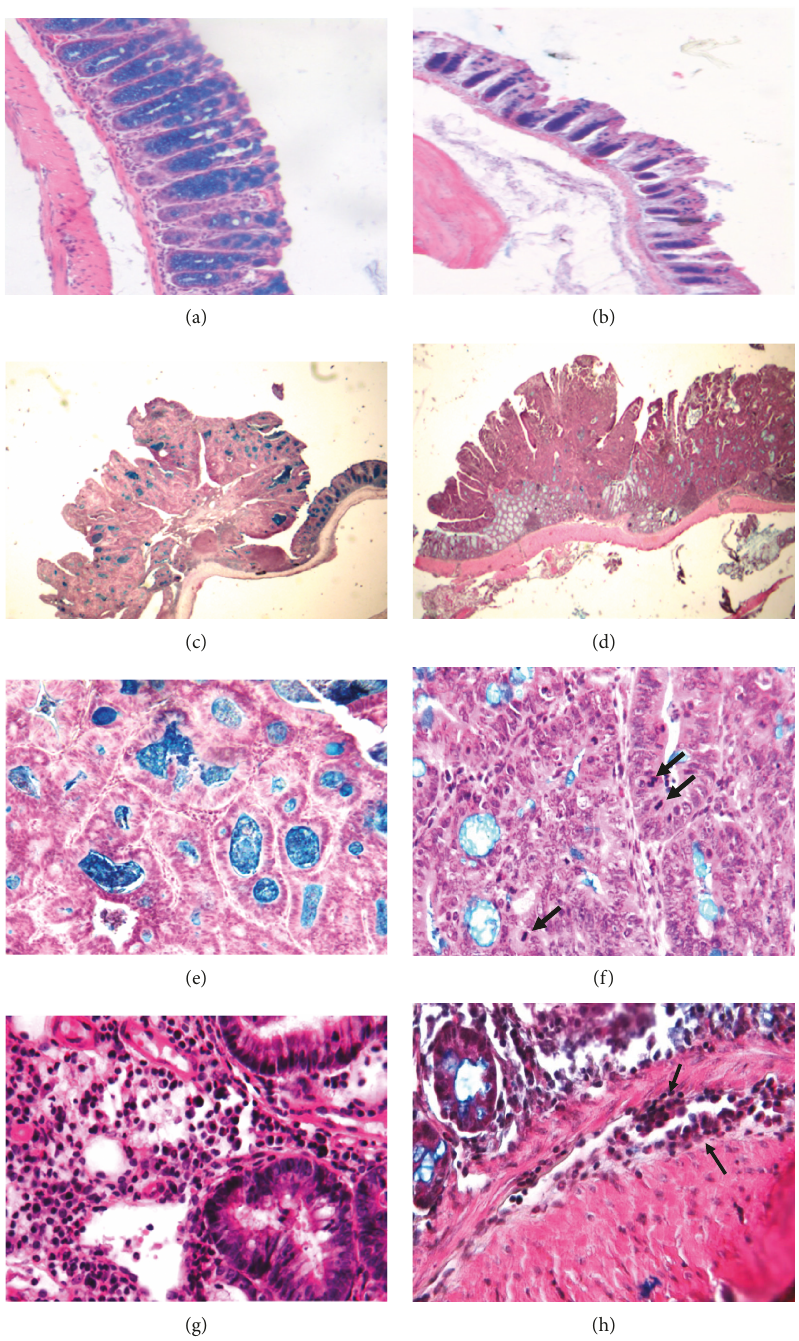
Figure 3: MIF-de fi cient mice have worse tissue damage than WT mice. Representative comparative micrographs of MIF -/- and WT lesions. (a) Normal histological structure of colonic mucosa from WT mice. (b) In comparison to those in WT mice, colonic crypts are shorter in MIF -/- mice. (c) Polypoid well-di ff erentiated adenocarcinoma in WT mice. (d) MIF -/- mice show larger tumors than WT mice. (e) Tumors from WT mice are composed of neoplastic cells organized in well-di ff erentiated glands, many of which show detached necrotic cells and abundant Alcian blue-positive material that correspond to mucin, denoting well-di ff erentiated adenocarcinoma. (f) In contrast, MIF -/- mice showed neoplastic glands with more strati fi ed epithelium, reduced mucin production, and numerous mitotic fi gures (arrows) denoting a lower di ff erentiation grade. (g) High-power micrograph of the base from the tumor that developed in WT mice, showing well- di ff erentiated glands revisited by neoplastic epithelial cells exhibiting a large hyperchromatic nucleus. The surrounding stroma shows numerous in fl ammatory cells and distended blood vessels. (h) In contrast, the base of the tumor that developed in MIF -/- mice shows smaller mildly di ff erentiated glands, the surrounding tissue (smooth muscle) shows scarce in fl ammatory in fi ltration and neoplastic cuboidal cells, and some of these cells are in the lumen of blood vessels denoting hematogenous invasion (arrows). Photographs are representative of three independent experiments, n = 3 mice per group, and samples were analyzed by a blinded